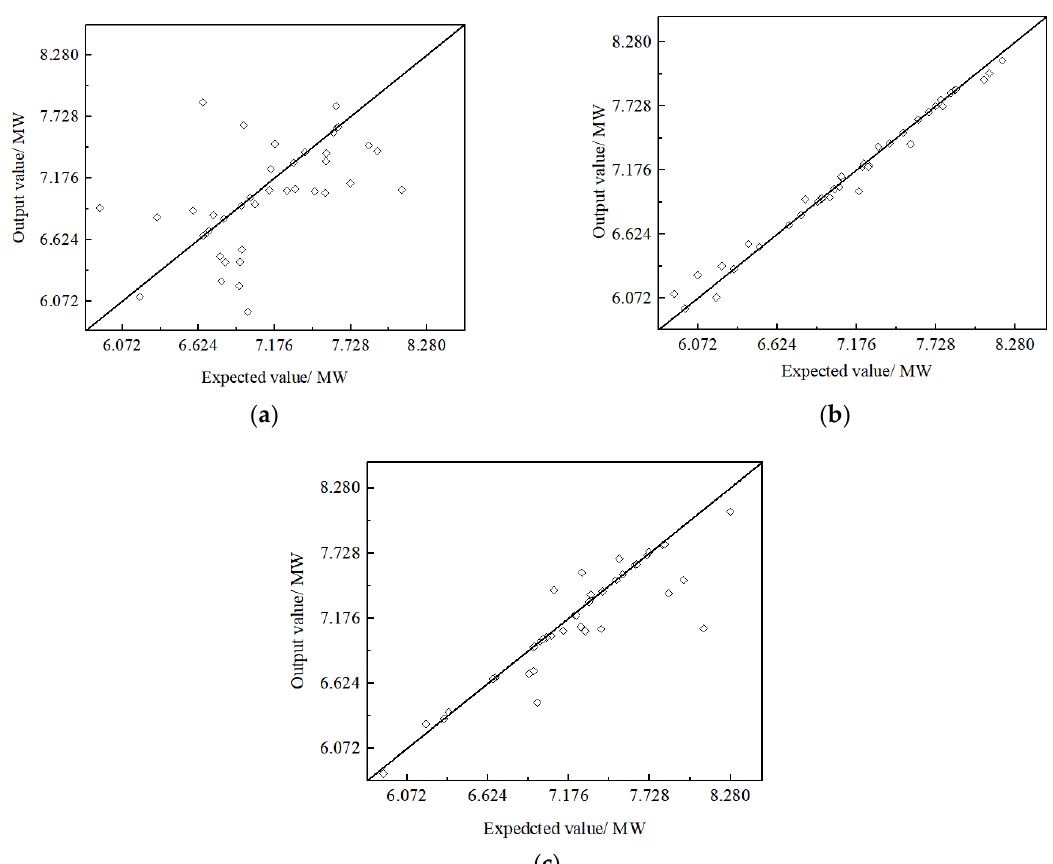
Figure 5. Accuracy and reliability of BPNN, RBFNN, and GRNN models. ( a ) BPNN model; ( b ) RBFNN model; ( c ) GRNN model.